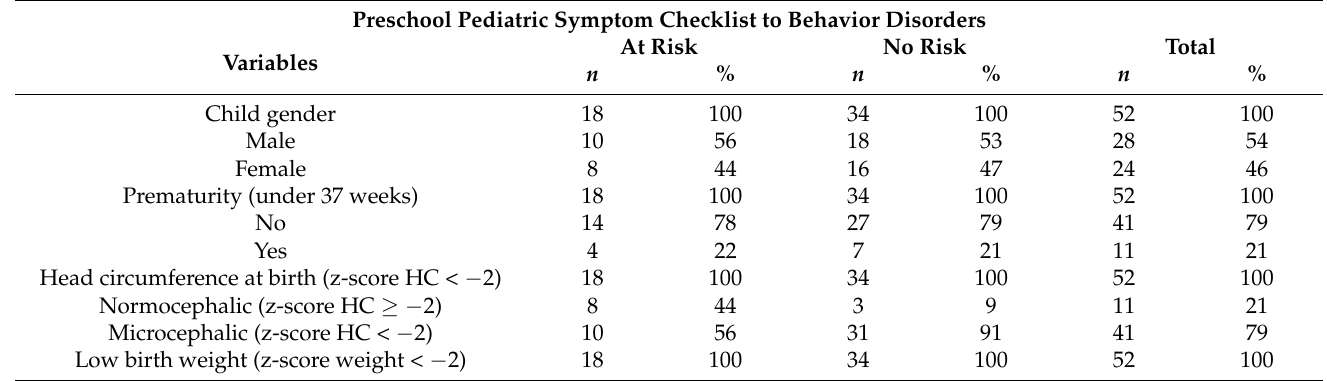
Table 2. Distribution of children ( n = 52) according to risk of behavioral alteration assessed with the Preschool Pediatric Symptom Checklist of the SWYC